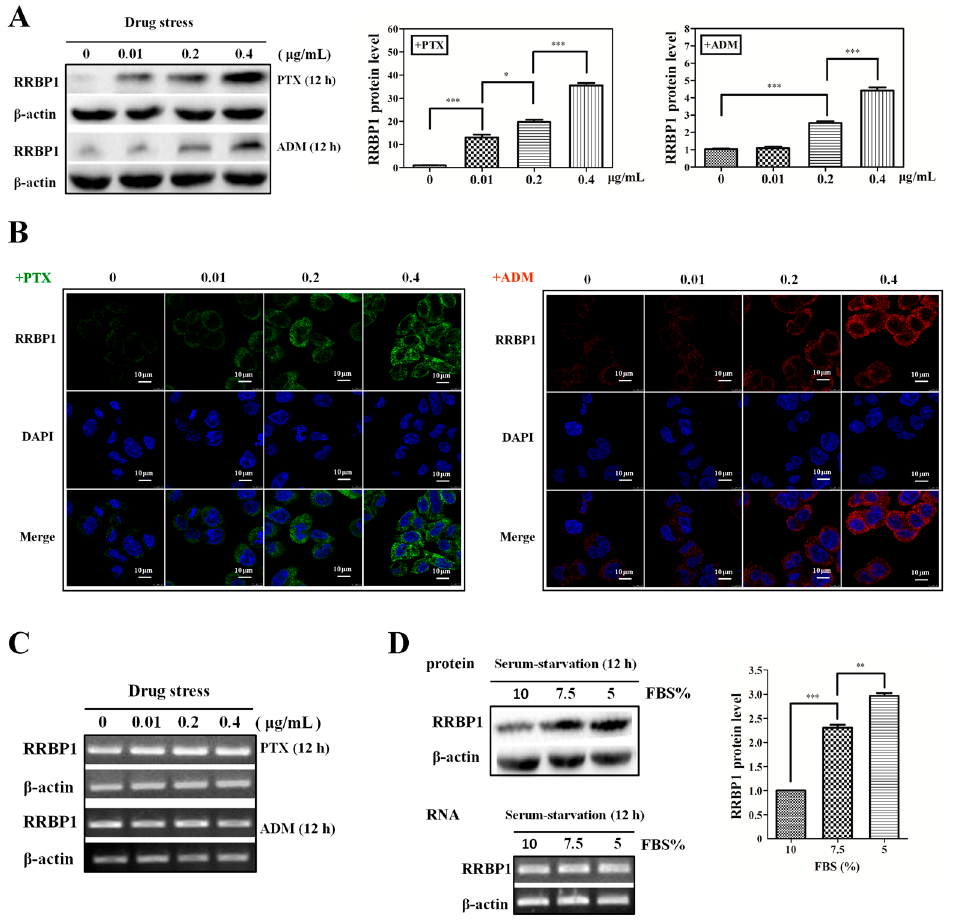
Figure 1. Enhanced protein synthesis contributes to overexpression of ribosome binding protein 1 (RRBP1) during stress conditions. ( A ) Human hepatocellular carcinoma cells (Bel7402 cells) were treated with paclitaxel (PTX) or adriamycin (ADM) at different doses (0.01, 0.2, 0.4 µ g/mL) respectively, for 12 h. The protein expression of RRBP1 was examined via Western blot analysis and normalized to β -actin. The RRBP1/ β -actin ratio from treated cells was compared with the ratio from untreated cells, which is set to 1 (*: p < 0.05; ***: p < 0.0005); ( B ) Immunofluorescence showed dose-dependent cytoplasm expression of RRBP1 in Bel7402 cells treated with PTX or ADM; ( C ) mRNA expression levels of RRBP1 after treatment with increasing concentrations of PTX or ADM in Bel7402 cells. mRNA levels were determined with reverse transcription-PCR (RT-PCR); and ( D ) the expression of RRBP1 protein was increased during serum starvation in Bel7402 cells. RT-PCR and Western blotting showed different levels of transcription and translation of RRBP1 in Bel7402 cells growing at serum-starvation and normal conditions (**: p < 0.005; ***: p < 0.0005).